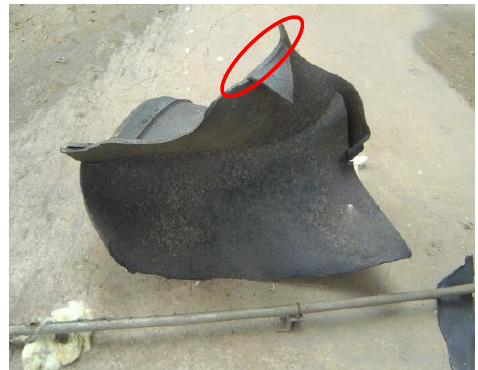
Figure 10. The photo of the cracked blade in the A fan.